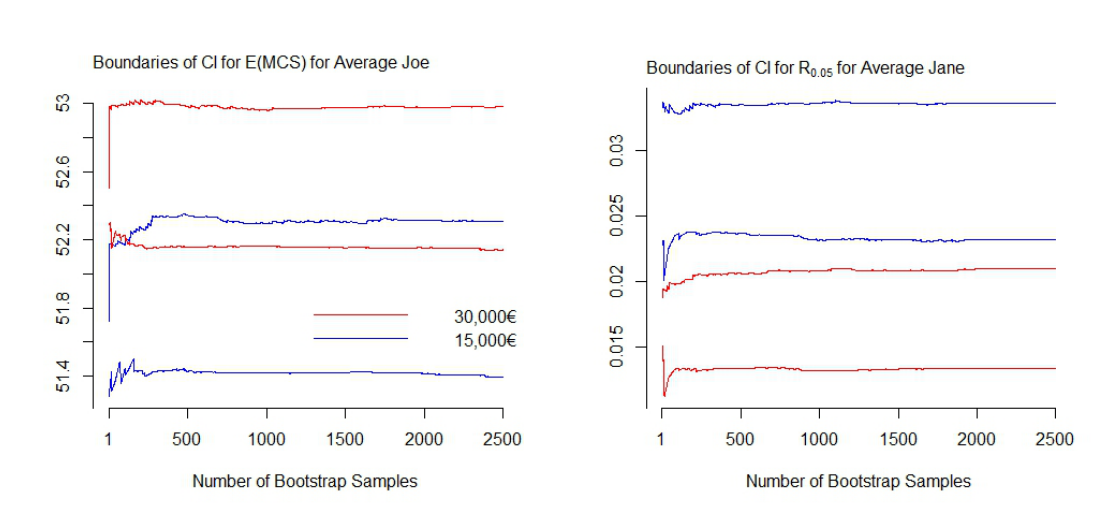
Figure A5. Boundaries of bootstrap confidence intervals for two distributional measures resulting from the GA model with an increasing number of bootstrap samples. Right : Expectation of MCS scores; left : Risk measure R 0.05